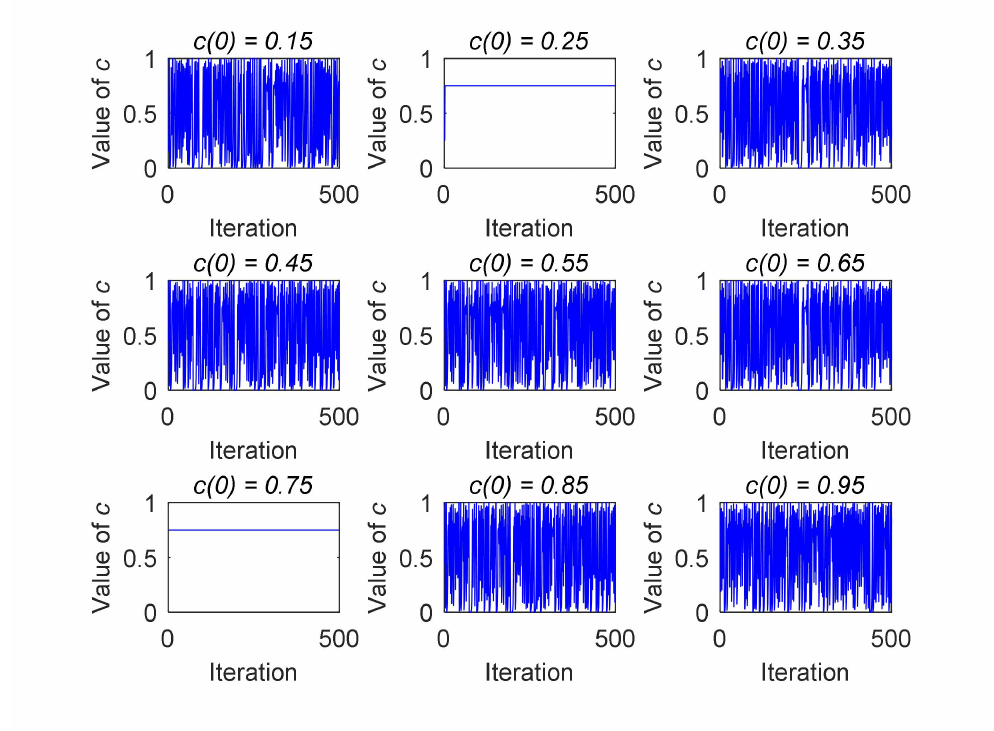
Figure 4. Chaotic sequence with different c ( 0 ) values. Table 1. Optimal value with different c(0)